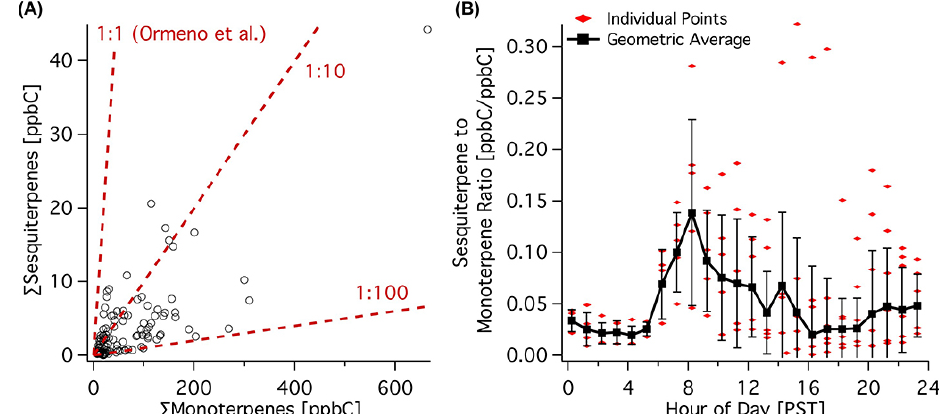
Figure 3. (A) The comparison of quantified sesquiterpenes to monoterpenes during the spring at Lindcove shows considerable variance in their ratio to each other. The 1:1 ratio expected by Ormeno et al. (2010) is shown, but is not reached due to measurements of a partial suite of sesquiterpenes and their greater atmospheric reactivity. (B) The diurnal pattern of sesquiterpenes to monoterpenes shows a higher ratio during the day than at night. Ratios are the highest early in the morning possibly due to lower levels of atmospheric oxidants (OH and O 3 ) in the morning and the presence of fresh emissions accumulating after sunrise in a shallow boundary layer.